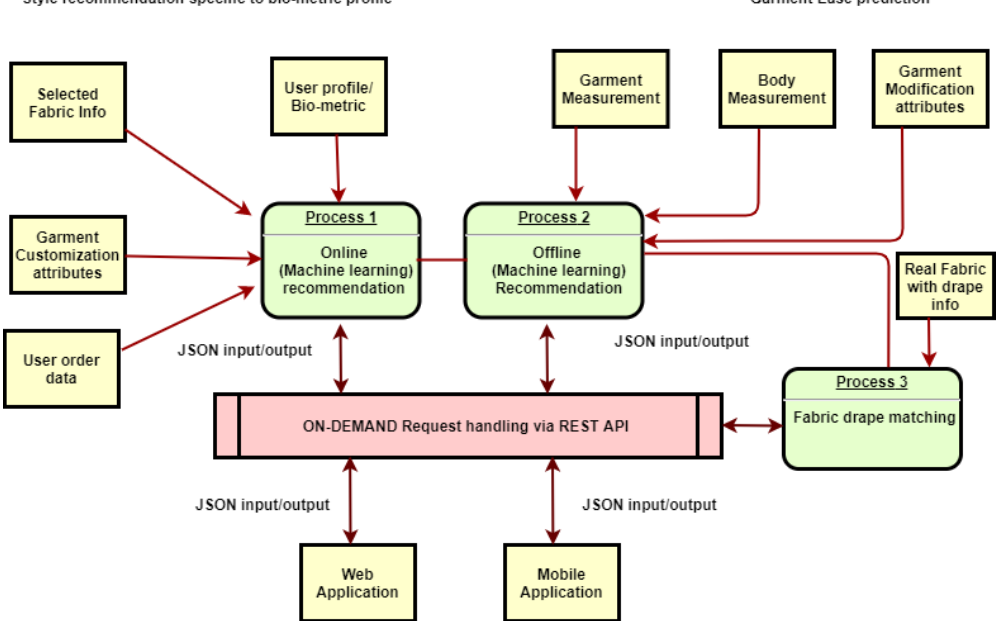
Figure 1. Data-driven service architecture.